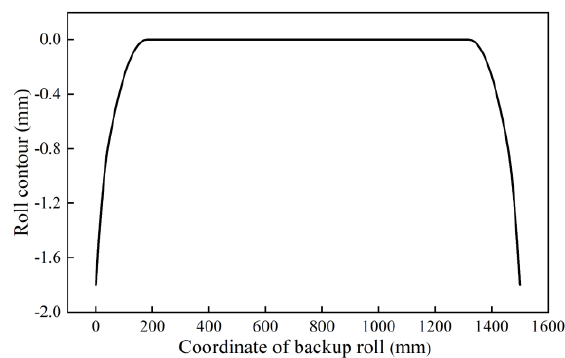
Figure 3. Backup roll contour.